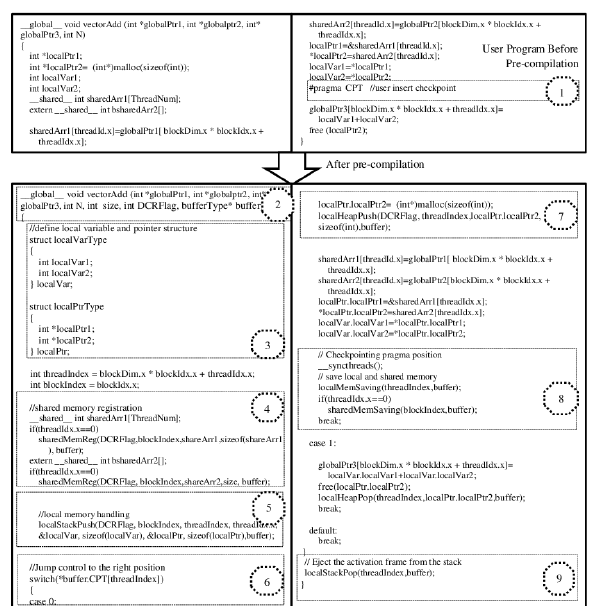
Fig. 4. An Example of Device Side